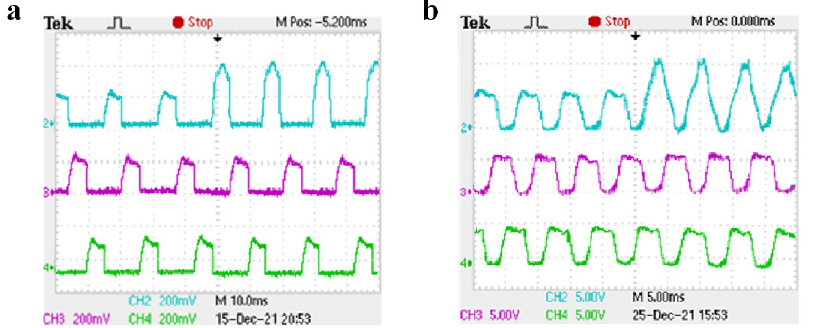
Fig 19. The short-circuit fault of A-phase SA2 experimental waveform. (a) The speed is 500 r/min. (b) The speed is 1000 r/min.